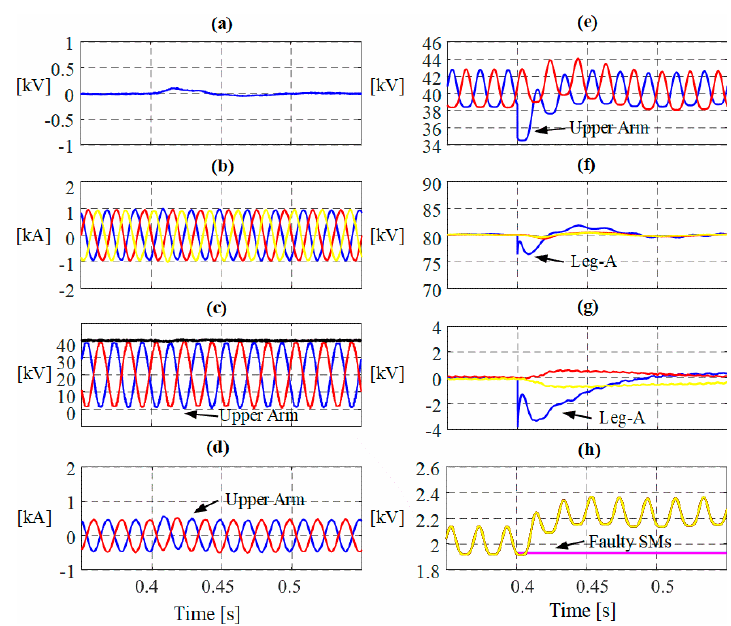
Figure 11. Simulation waveforms of the MMC under SM fault and control scheme-B operates in reactive power mode: ( a ) dc current, ( b ) ac current, ( c ) leg A upper and lower arm voltages superimposed on its common-mode voltage, ( d ) leg A upper and lower arm currents, ( e ) leg A upper and lower capacitor voltage sums, ( f ) common-mode capacitor voltage sums of three phase-legs, ( g ) di ff erential-mode capacitor voltage sums of three phase-legs, and ( h ) leg A upper arm SM voltages.